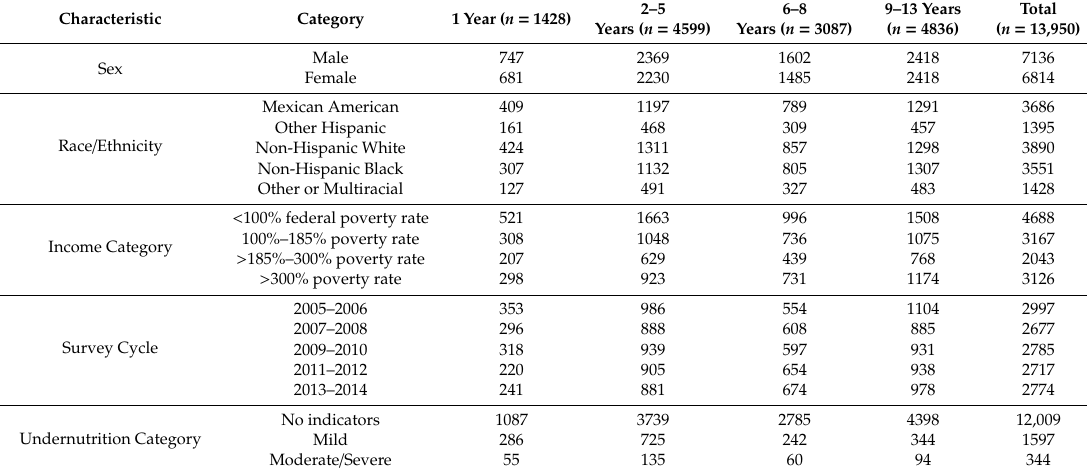
Table 2. Unweighted sample sizes of demographic and undernutrition characteristics by age categories of US children 1–13 years of age ( n = 13,950).